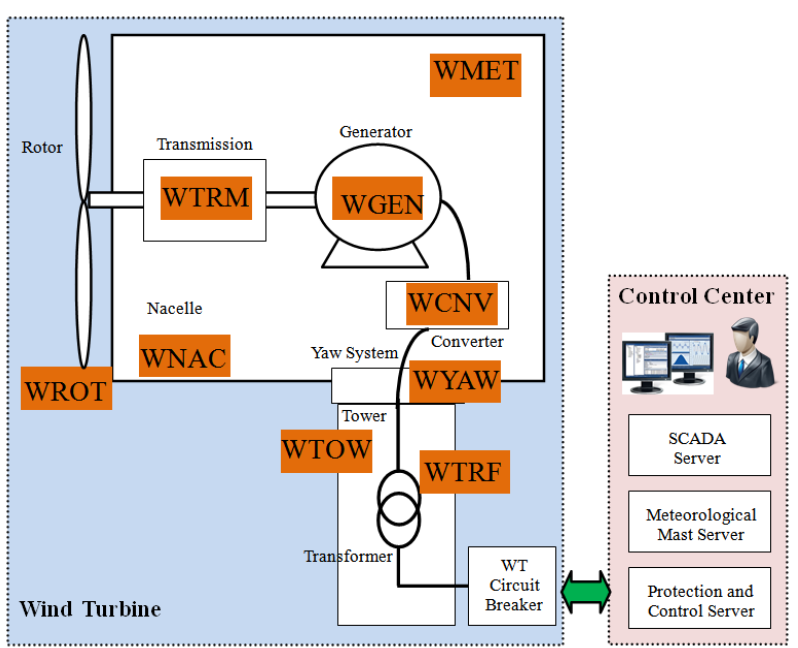
Figure 3. Wind turbine model with logical